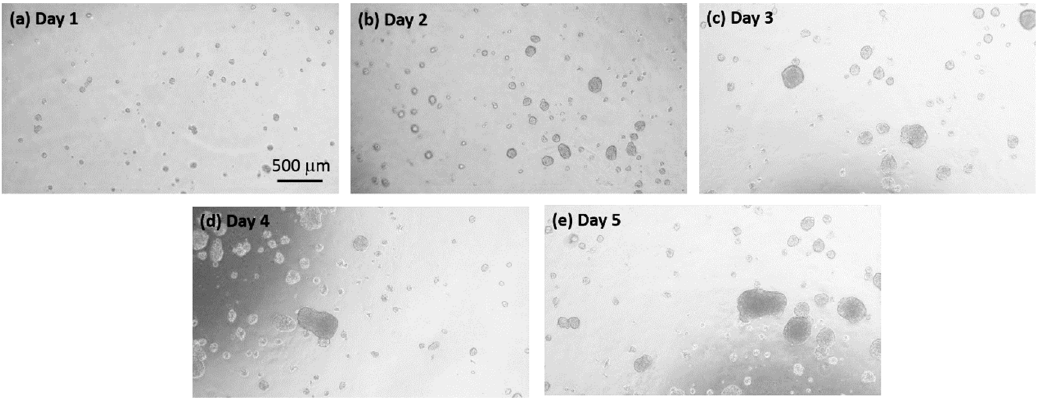
Figure 4. Microscopic images of cell colonies captured at the time points of Day ( a ) 1, ( b ) 2, ( c ) 3, ( d ) 4, and ( e ) 5, respectively.